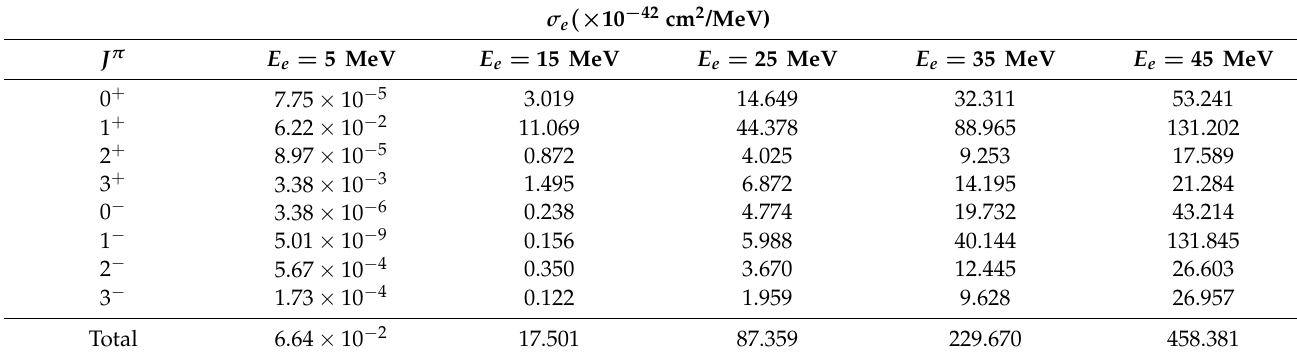
Table 2. Partial e − -capture cross-sections (in 10 − 42 MeV − 1 cm 2 ) on the 56 Fe isotope for different incident electron energy E e